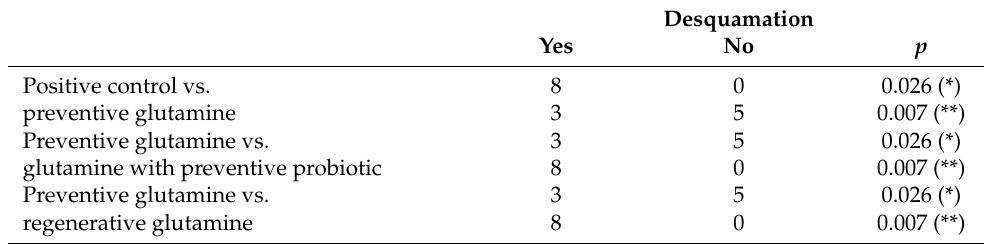
Table 2. Comparison between the preventive and regenerative in desquamation.